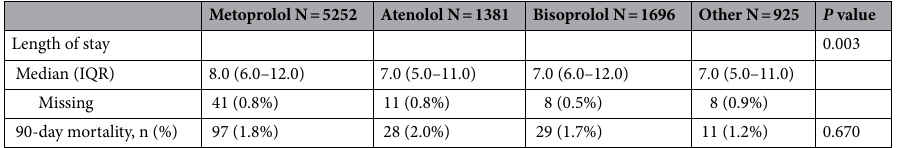
Table 3. Crude outcomes. N, Total number of patients.